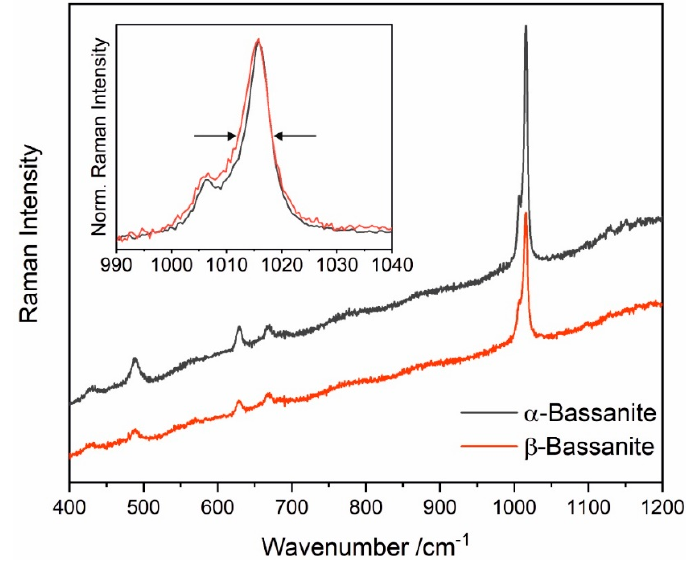
Figure 12. Raman spectra of two samples of α -bassanite and β -bassanite. The inset shows a baseline-corrected and normalised version of the spectral range around the ν 1 band of bassanite.